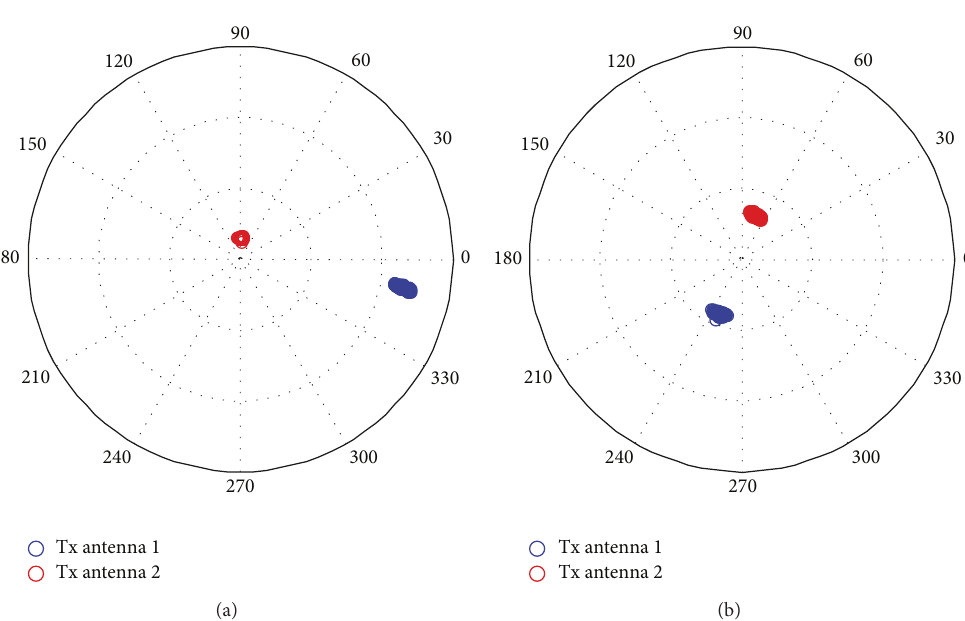
Figure 3: Estimates of H 0 . (a) Receive antenna 1 . (b) Receive antenna 2 .